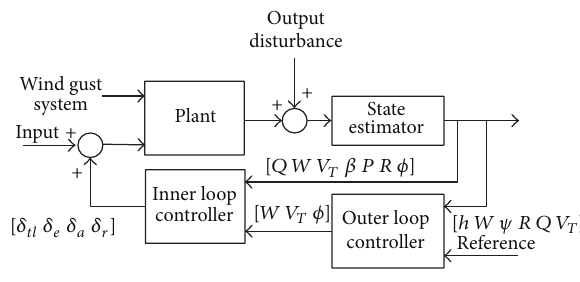
Figure 2: Controller